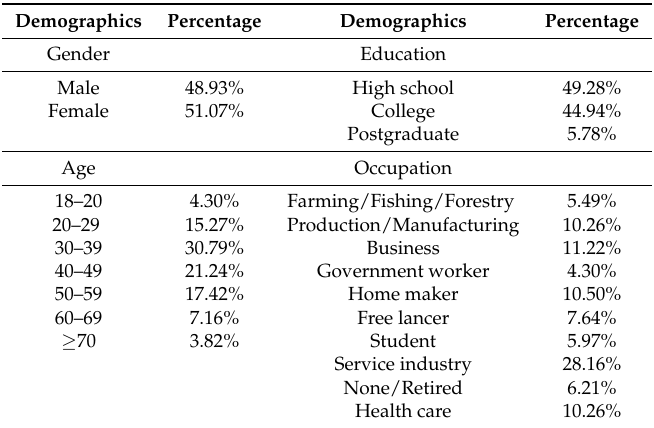
Table 2. Socio-demographic profile of respondents.